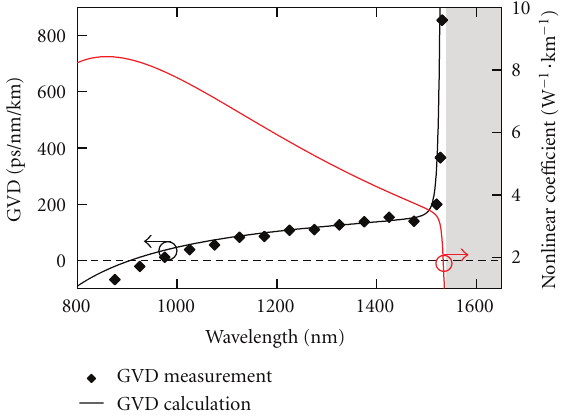
Figure 3: Calculated GVD curve of the solid-core PBG fiber 1 (solid black line, left axis), and corresponding measurements with a white-light interferometry setup (markers). Spectral evolution of the computed NL coe ffi cient (red line, right axis). The gray area depicts the region outside the first PBG transmission